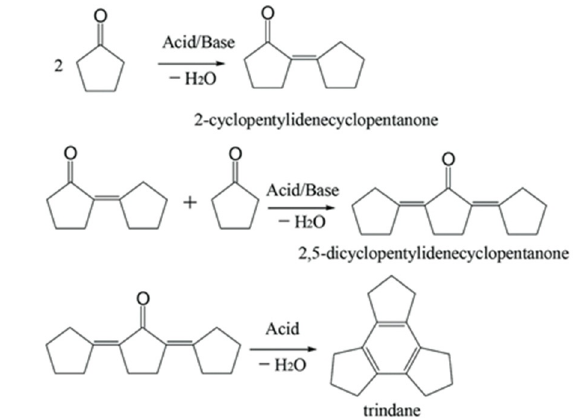
Figure 8. Reaction figure of a cyclopentanone self-condensation reaction. Adapted with permission from [97]. Copyright (2015), Royal Society of Chemistry.